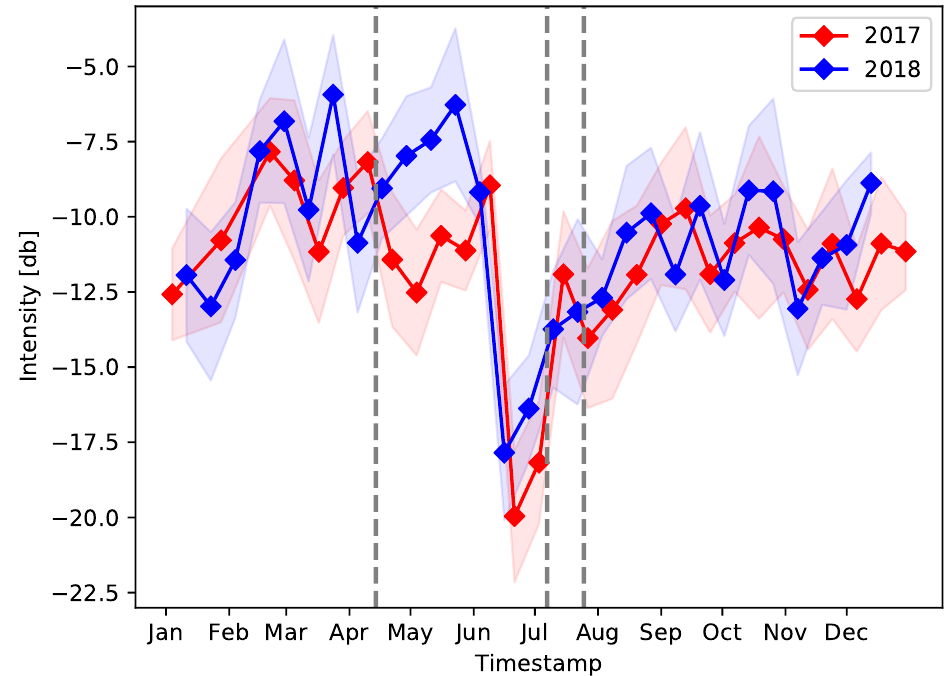
Figure 7. Temporal variation in backscattering from surveyed paddy field F26. The red and blue lines denote the mean variations during the years 2017 and 2018, respectively. The shaded area denotes the limits of the average plus/minus one standard deviation. The vertical dashed lines denote the date of the field survey (25 July 2018) and the dates of the ALOS-2 SAR images that were provided for the early